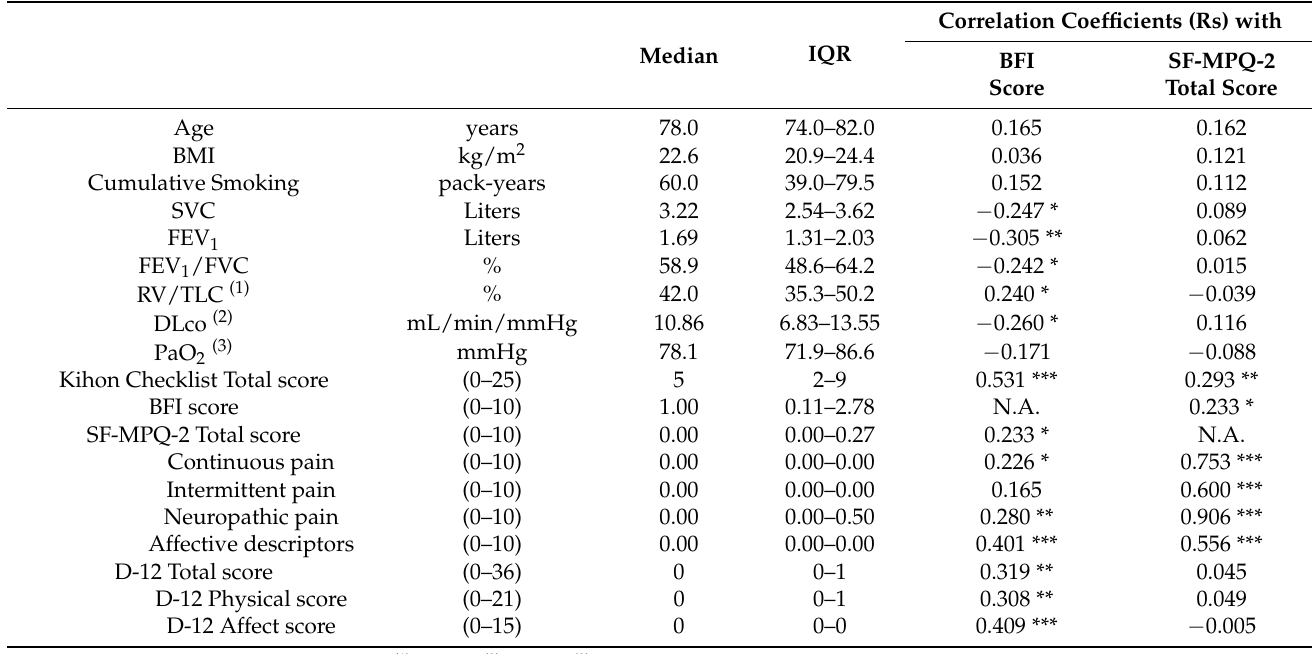
Table 1. Baseline characteristics in 89 subjects with COPD and Spearman’s rank correlation coefficients with Brief Fatigue Inventory (BFI) and Short-form McGill Pain Questionnaire (SF-MPQ)-2 Total